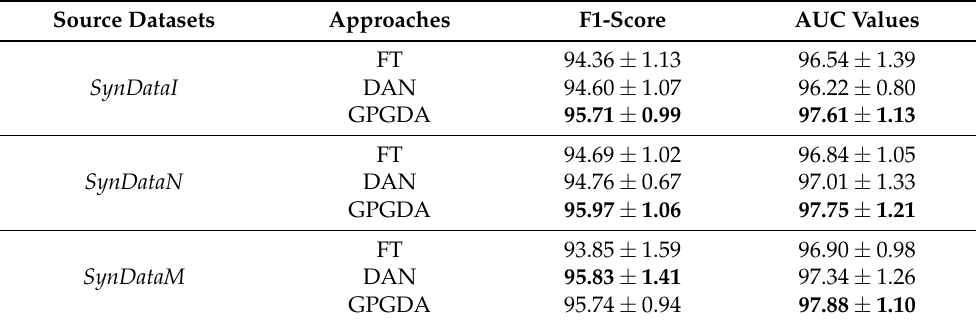
Table 1. Performance of the GPGDA algorithm in comparison with the baseline methods on the WBT dataset.